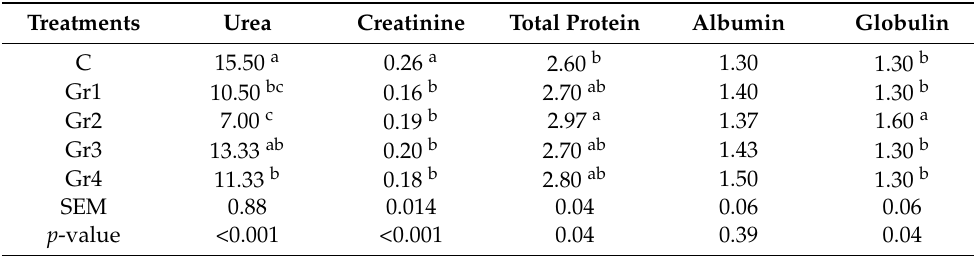
Table 5. Effects of variable concentrations of dietary CP and Lys on serum protein profile of broiler